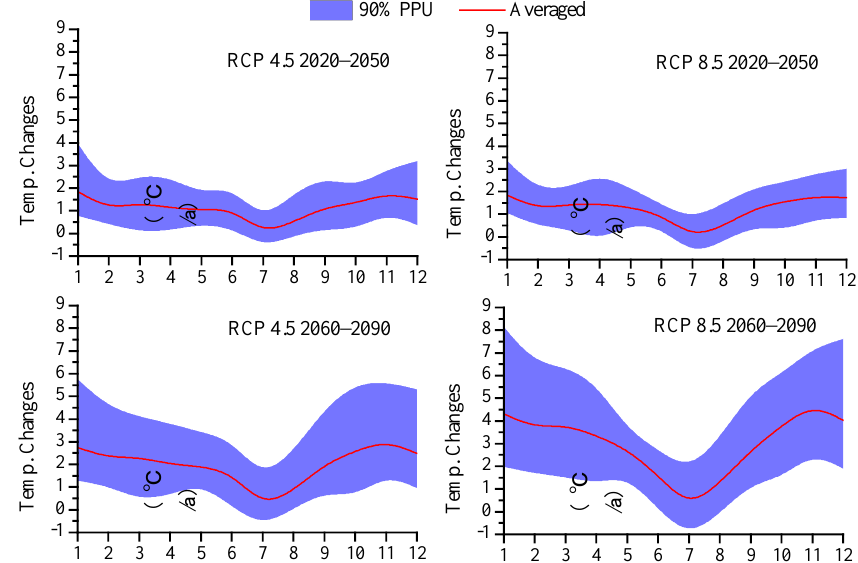
Figure 5. Future change tendency for the monthly temperature at different periods and under different climate scenarios. The term “Temp” represents temperature. The red line shows the median; the borderline represents 90% predictive uncertainty.